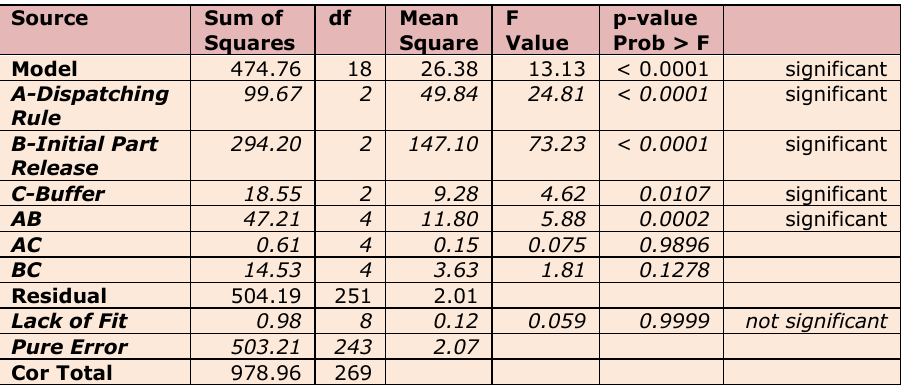
Table 7. ANOVA for the average flow time